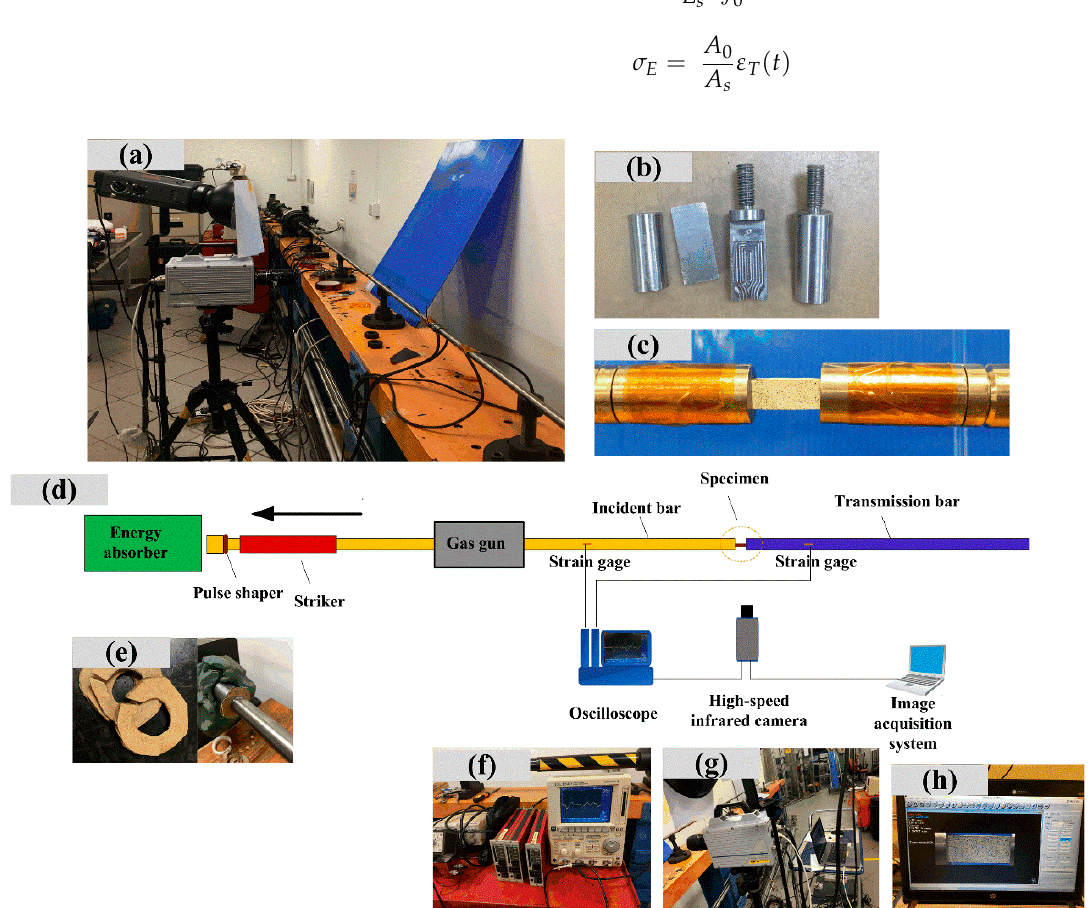
Figure 3. Split Hopkinson tensile bar system with a high-speed camera. ( a ) SHTB equipment, ( b ) Self-designed fixture, ( c ) Specimen with black and white speckles, ( d ) Schematic diagram of SHTB system, ( e ) Cardboard pulse-shapers, ( f ) Oscilloscope and strain instrument, ( g ) High-speed camera, ( h ) Data acquisition.